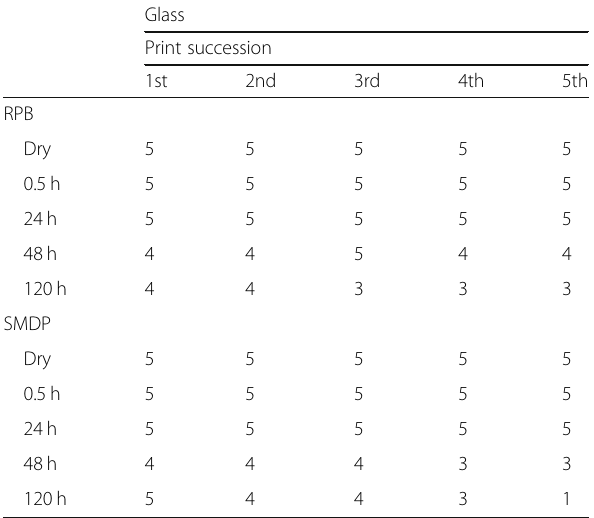
Table 1 Development of submerged and successive prints on glass using Robin powder blue and silver magnetic dual powder